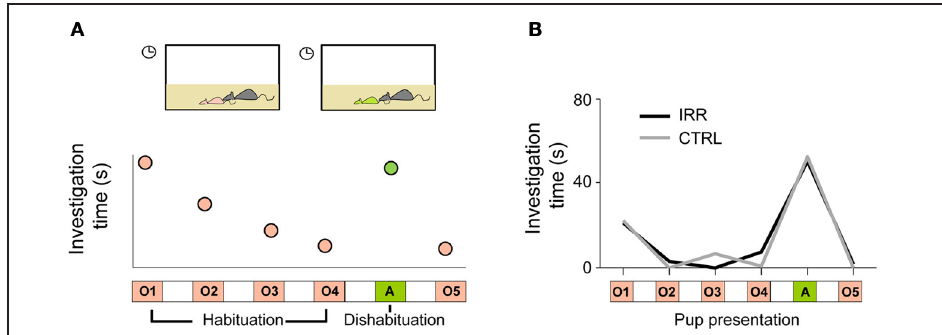
FIGURE 4 | (A) Schematic of the habituation/dishabituation protocol for testing pup discrimination. Repeated presentation of a mother’s own pup (O1 to O4) results in decreased investigation (measured as sniffing and grooming) time. When a pup from a different litter is presented (A: alien), investigation time increases—this shows that the tested subject can discriminate between the pups. (B) Both IRR and CTRL females discriminated own pups vs. an alien one (compare O4 to A; p < 0 . 05). Investigation time is shown as the median for each treatment.